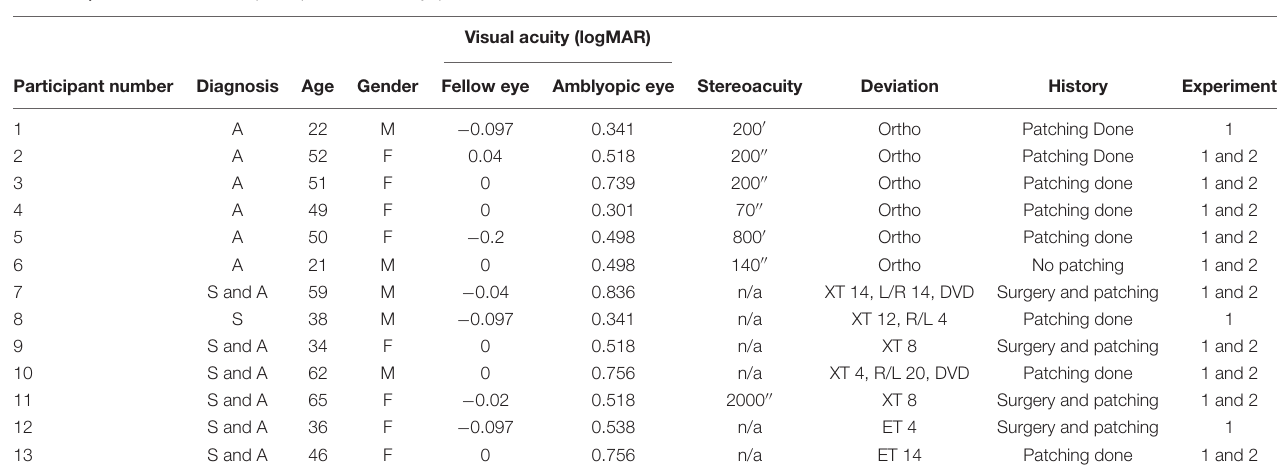
TABLE 1 | Clinical details of the participants with amblyopia.